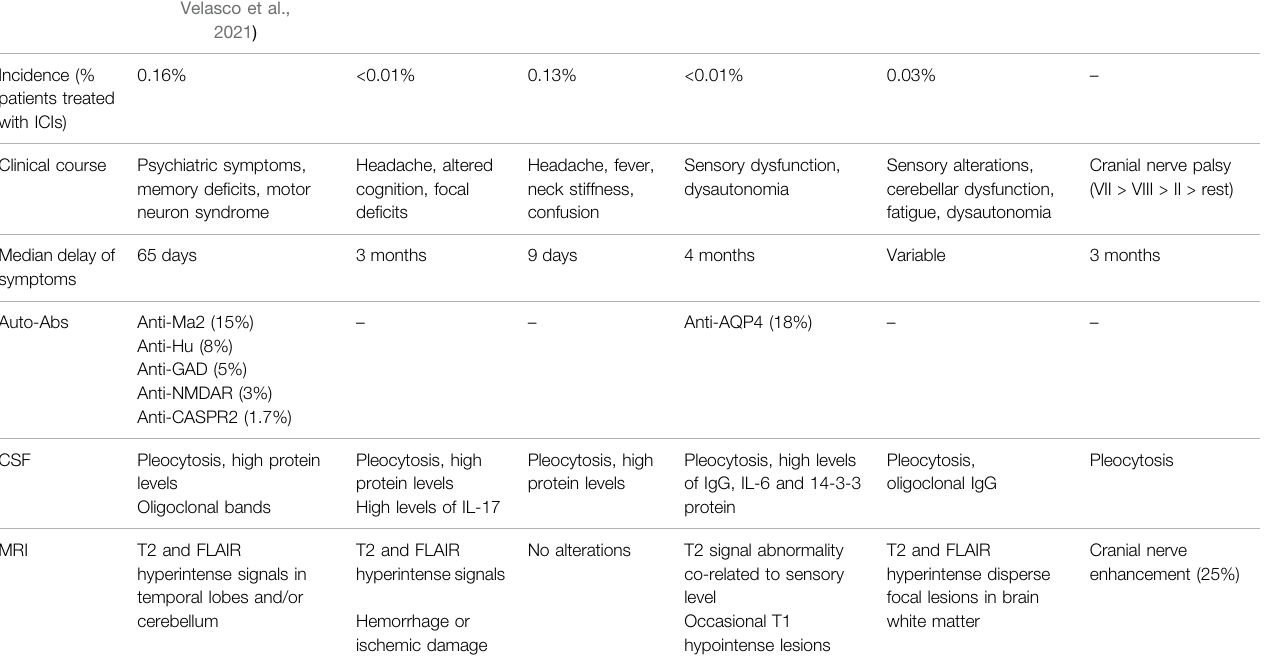
MS: multiple sclerosis; CND: cranial nerve disorders. CSF: cerebrospinal fl uid. MRI: magnetic resonance image.